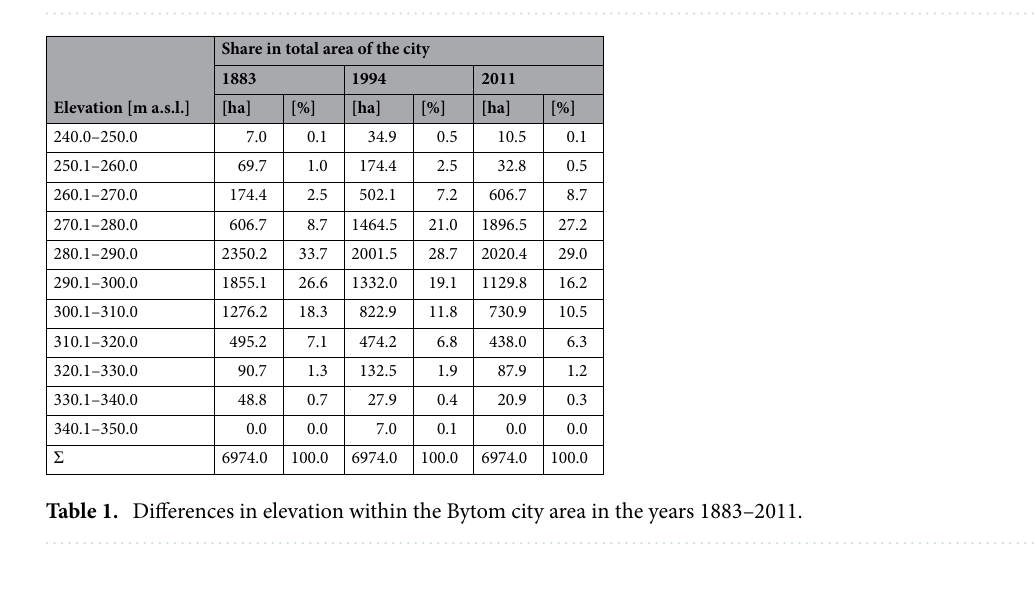
Figure 2. Land relief within the city of Bytom at the end of the nineteenth century (within present-day city limits): 1—city boundary; 2—absolute elevation [m a.s.l.].